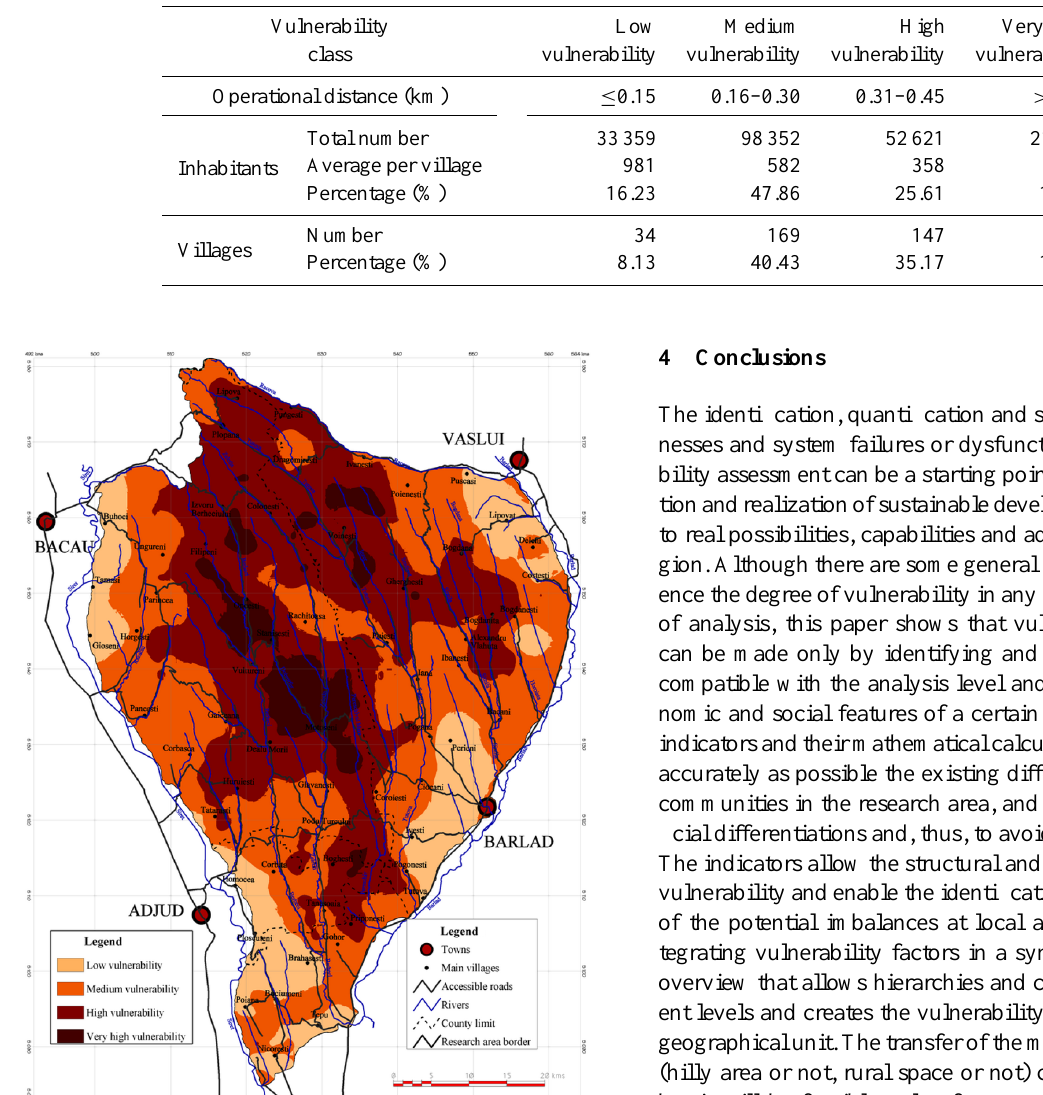
Table 6. Synthetic data on vulnerability factor 5 in Tutova Hills.